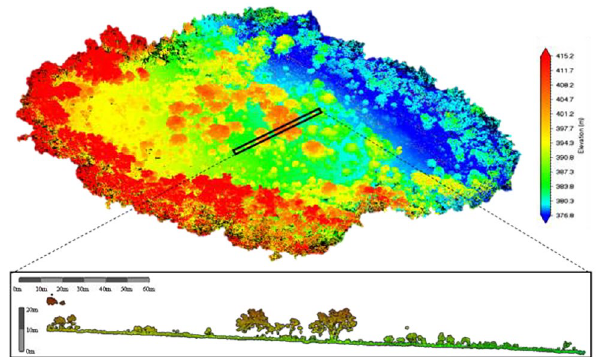
Fig. 4 a Surface point density map obtained through UAV-LiDAR sur-